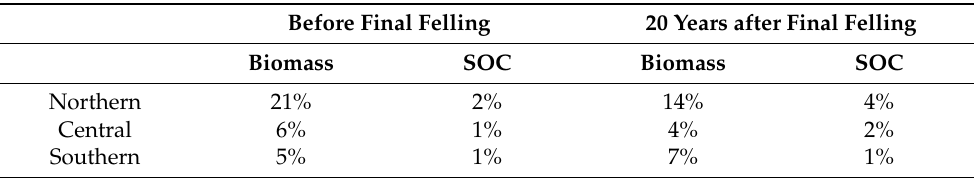
Figure 4. Modeled tree biomass ( a ), SOC in the organic layer ( b ) and N leaching ( c ) according to a fertilization scenario (red line) and a baseline scenario (black line). Vertical lines represent management activities: final felling (black solid line) and N fertilization events before final felling (grey dashed lines). Table 5. Fertilization effect, i.e., % difference in biomass and SOC between BAS and FERT scenario, before final felling and 20 years after final